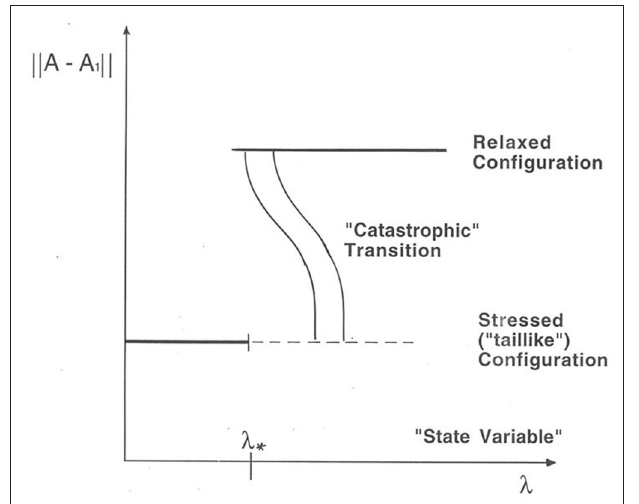
FIGURE 9 | A diagram illustrating the abrupt (“catastrophic”) transition of the magnetosphere from a highly stressed, or taillike, magnetic connection to a much more relaxed configuration. Several different physical pathways for such relaxation may be possible once the magnetosphere exceeds a critical value of a magnetospheric state variable λ * (adapted from Baker et al., 1999).